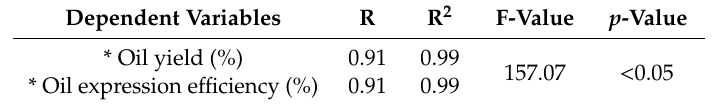
Table 7. ANOVA and correlation results of the e ff ect of relaxation time on oil expression e ffi ciency.